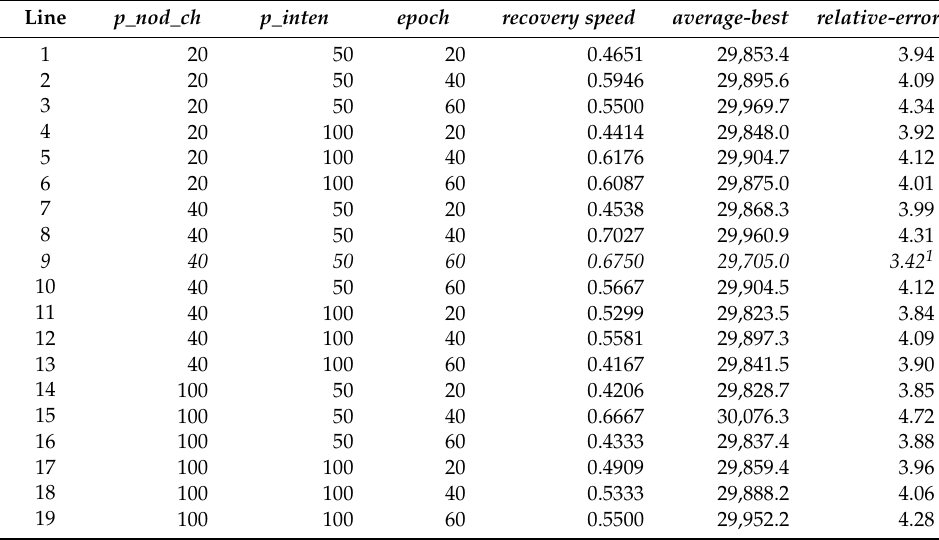
Table 4. Parameters and metrics for fl3795 , with ampl = 40.